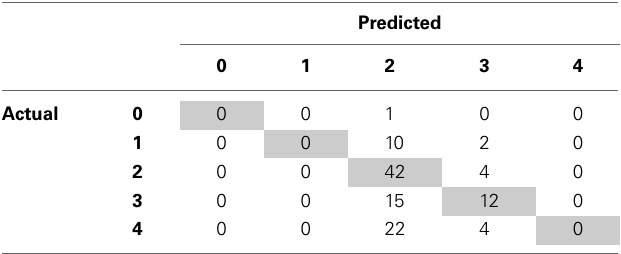
Table 3 | Confusion matrix for SVM-D revealing the model having difficulty distinguishing when an individual has a higher degree of trust toward their